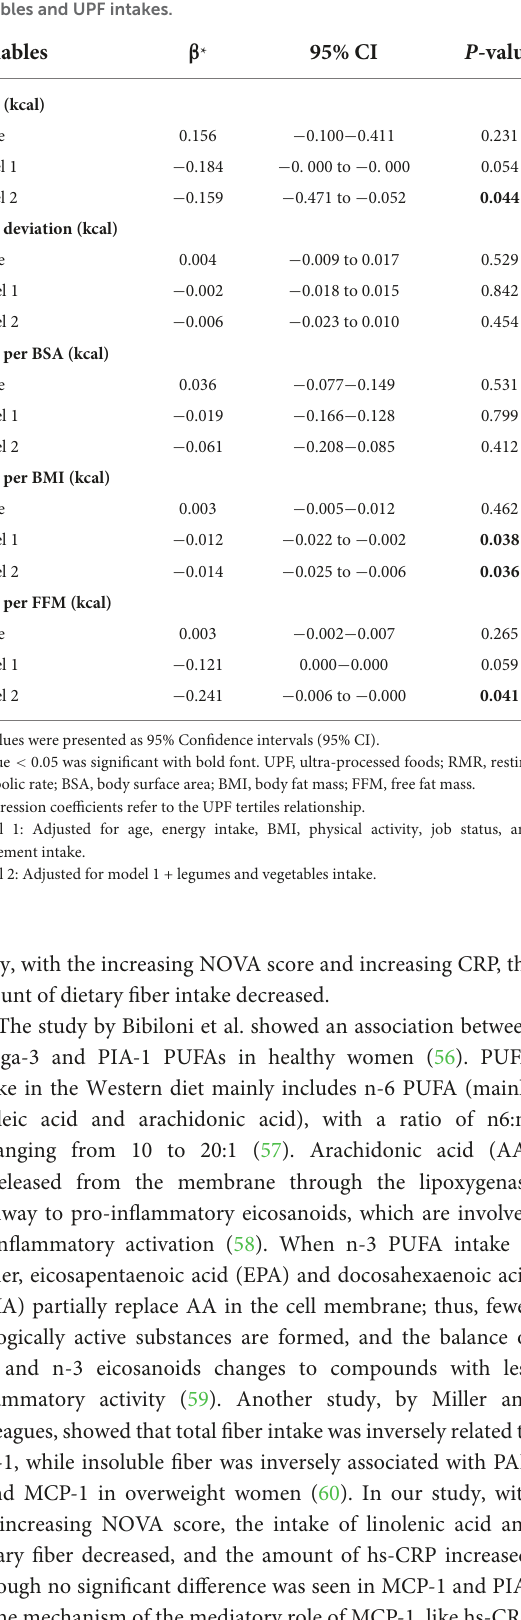
TABLE 4 Association between resting metabolic rate and related variables and UPF intakes.